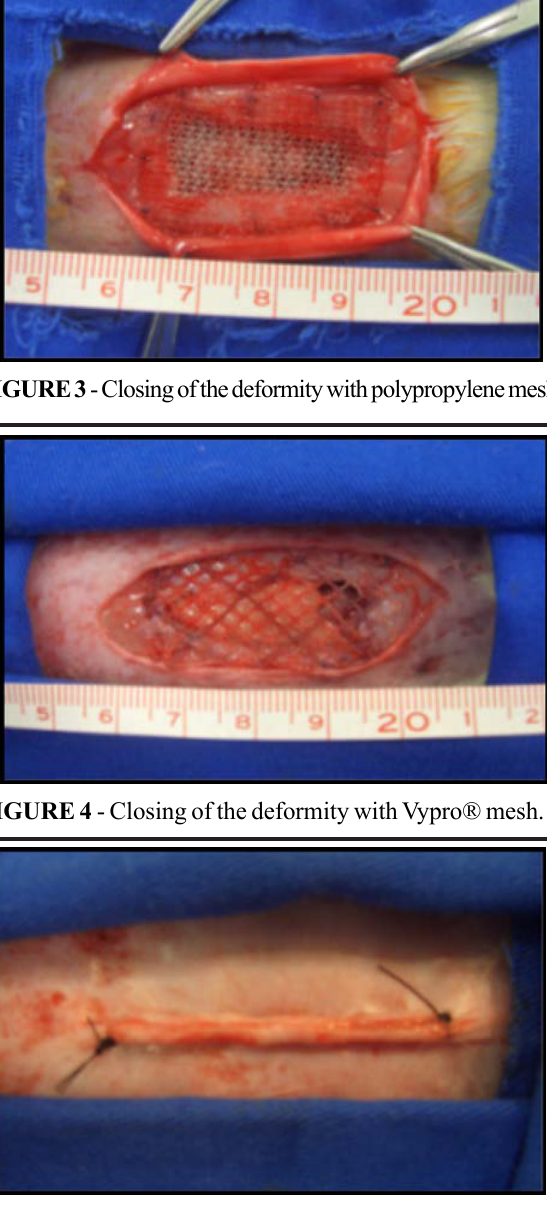
FIGURE 5 - Skin synthesis with greek- type suture.